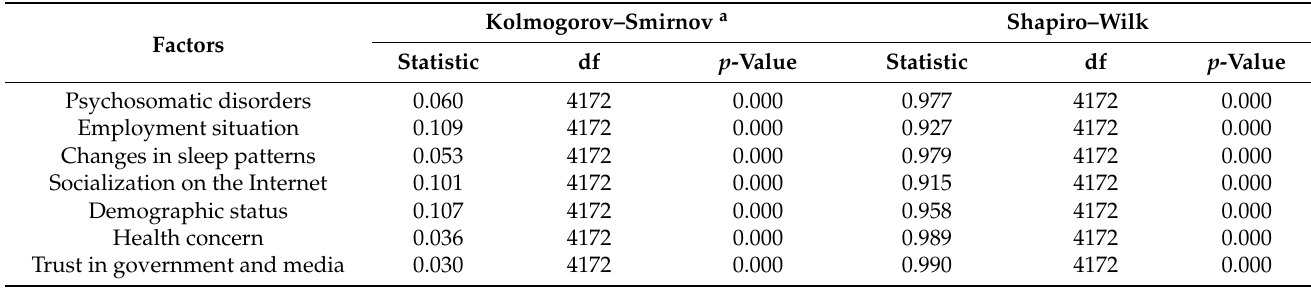
Table A1. Tests of normality for the seven factors